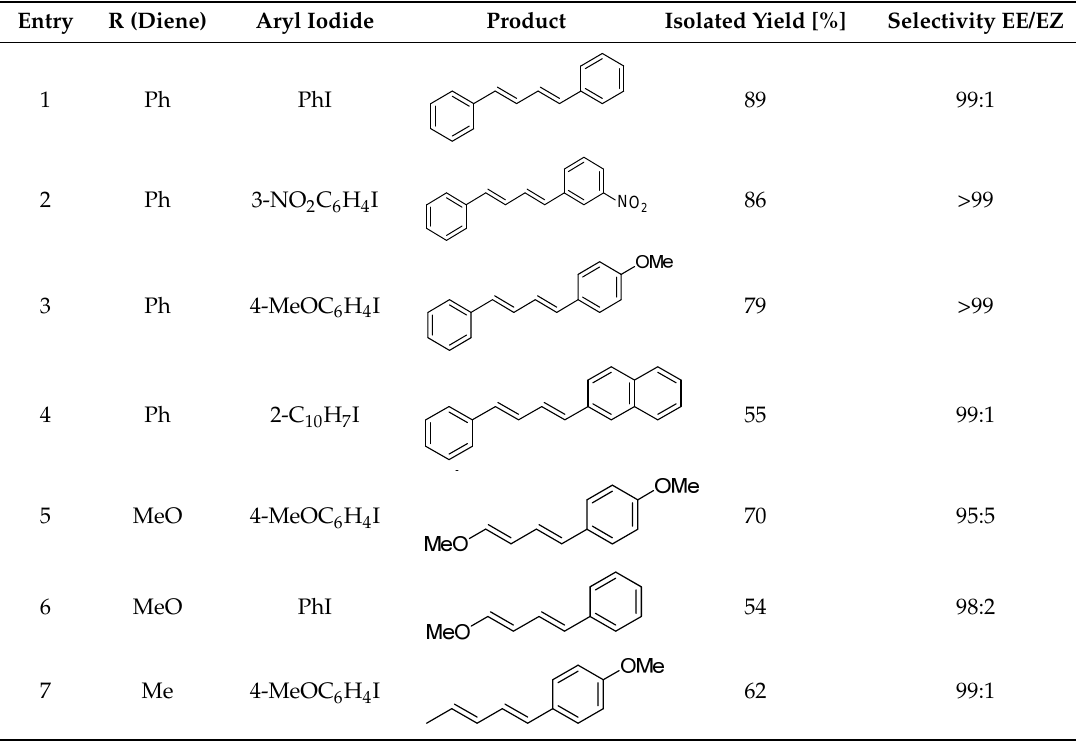
1 ‐ (triethoxysilyl)penta ‐ 1,3 ‐ dienein the synthesis of a stereodefined ( E , E , E ) ‐ 1,3,5 ‐ hexatriene derivative